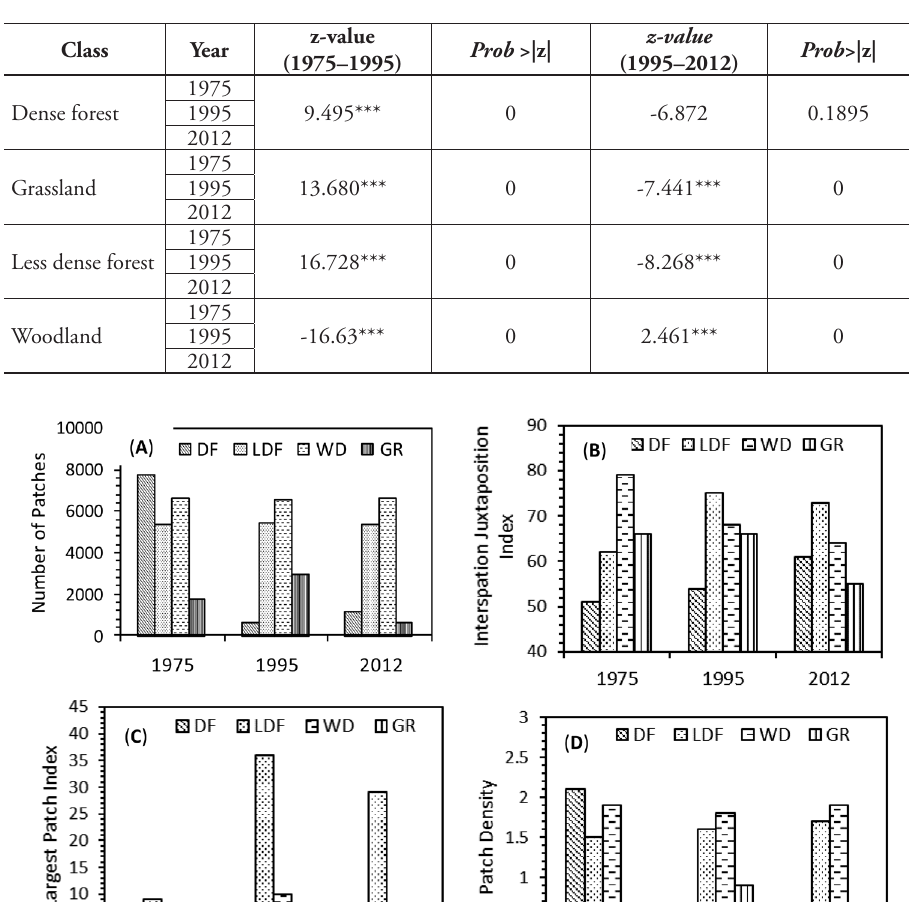
Table 3. Patch area compared by Mann-Whitney Tests.